Question: State the chart type depicted above.
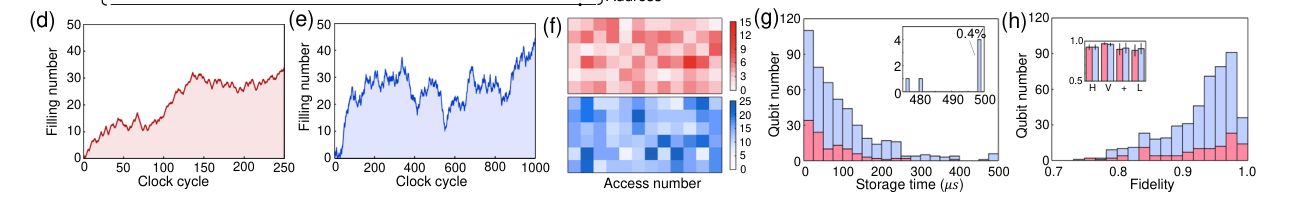
Answer: bar